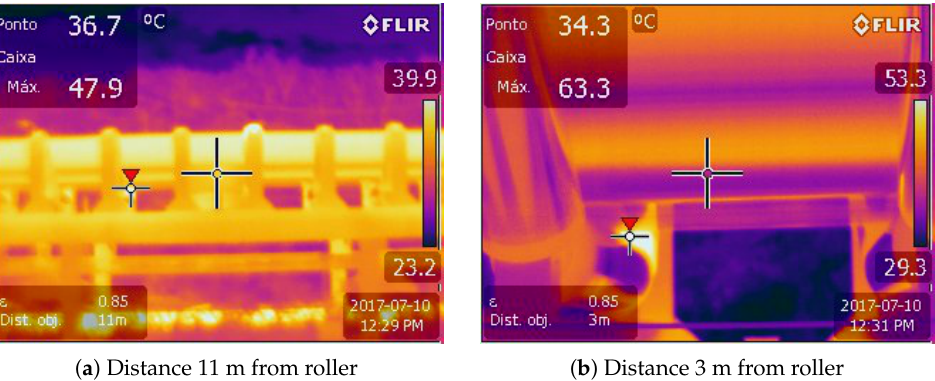
Figure 6. Distance influence in temperature measurement: ( a ) The photo was taken from 11 m, resulting in an image resolution of 1 pixels/cm 2 . ( b ) Same roller with an image taken 3 m away and a 22 pixels/cm 2 image resolution. Both values for resolution are